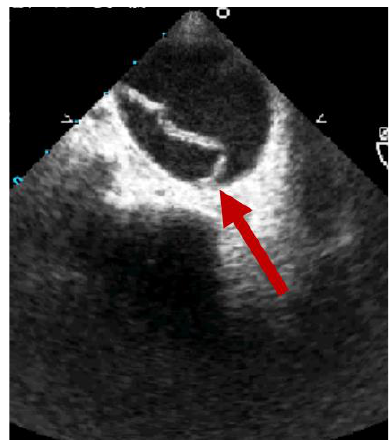
Figure 2. Transesophageal echocardiography showing the presence of an intimal flap (red arrow).